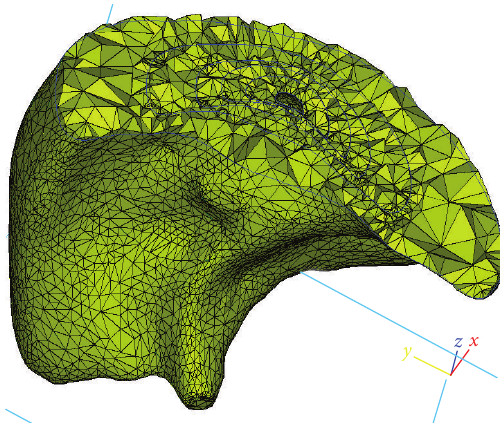
Figure 4: Volume mesh for the multilayer structure.